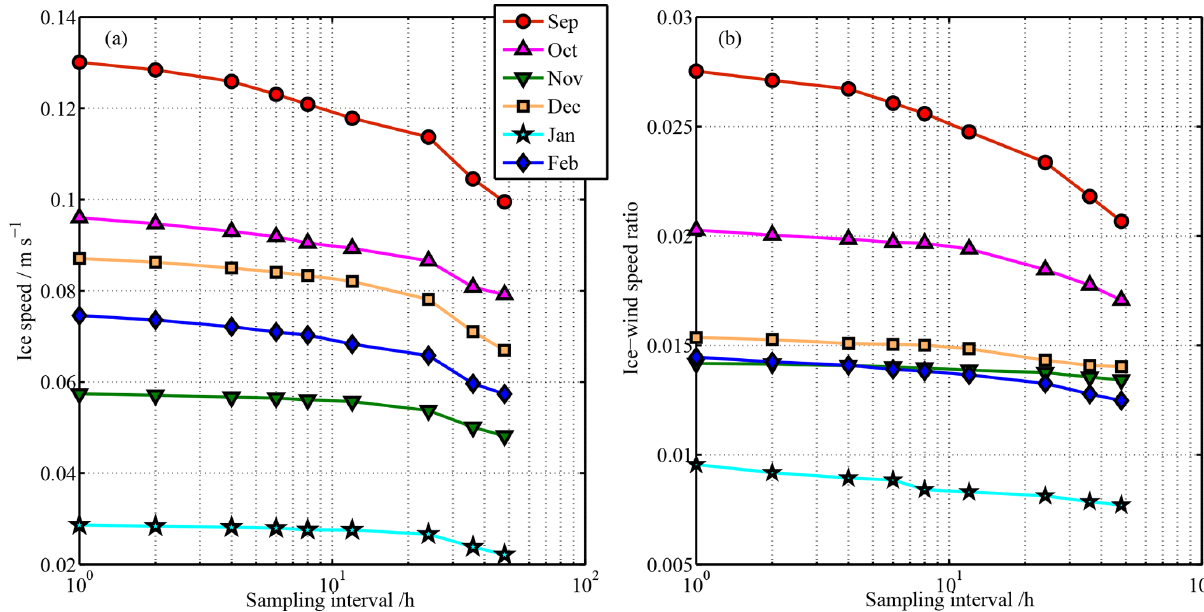
Figure 8. Changes in (a) ice speed and (b) IWSR as a function of position data resampling interval for various months in 2018/19.